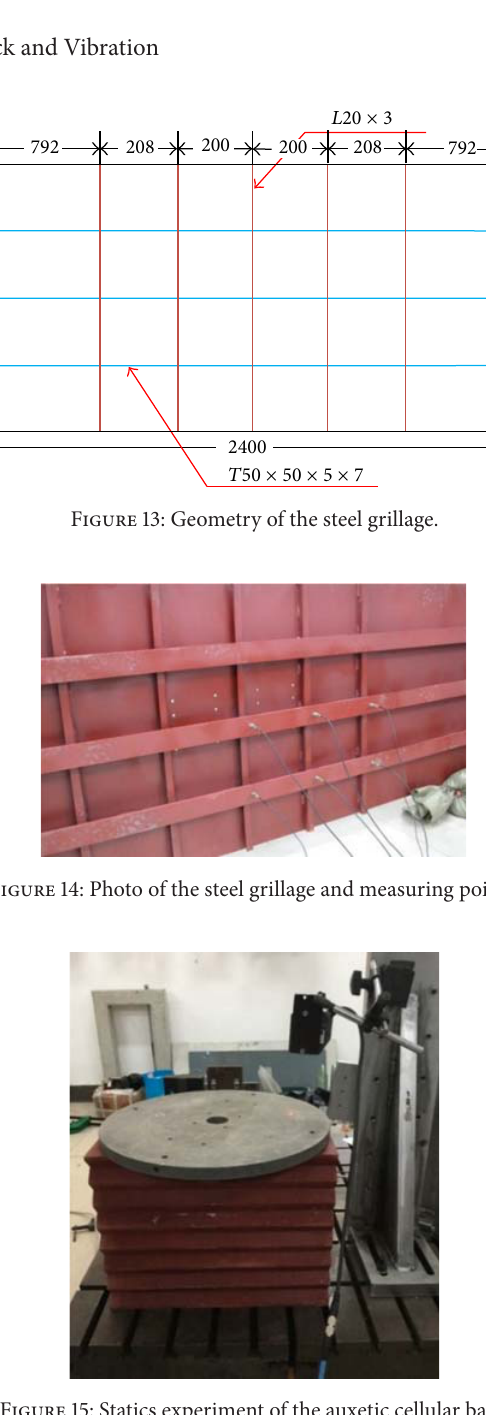
Figure 15: Statics experiment of the auxetic cellular base.